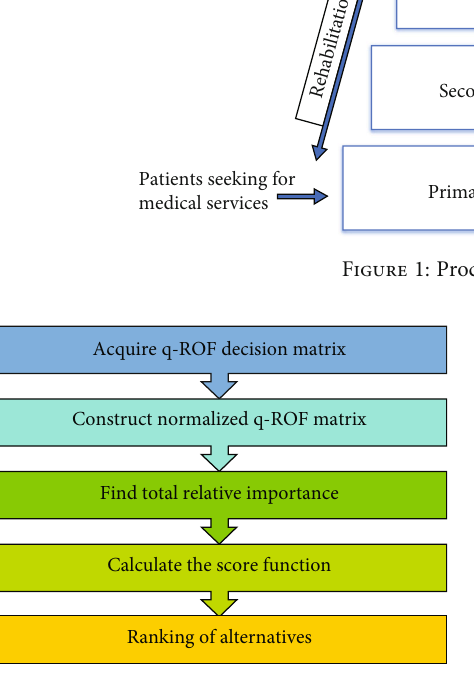
Figure 2: Procedures for patients to seek for medical services. Table 3: Symptoms for